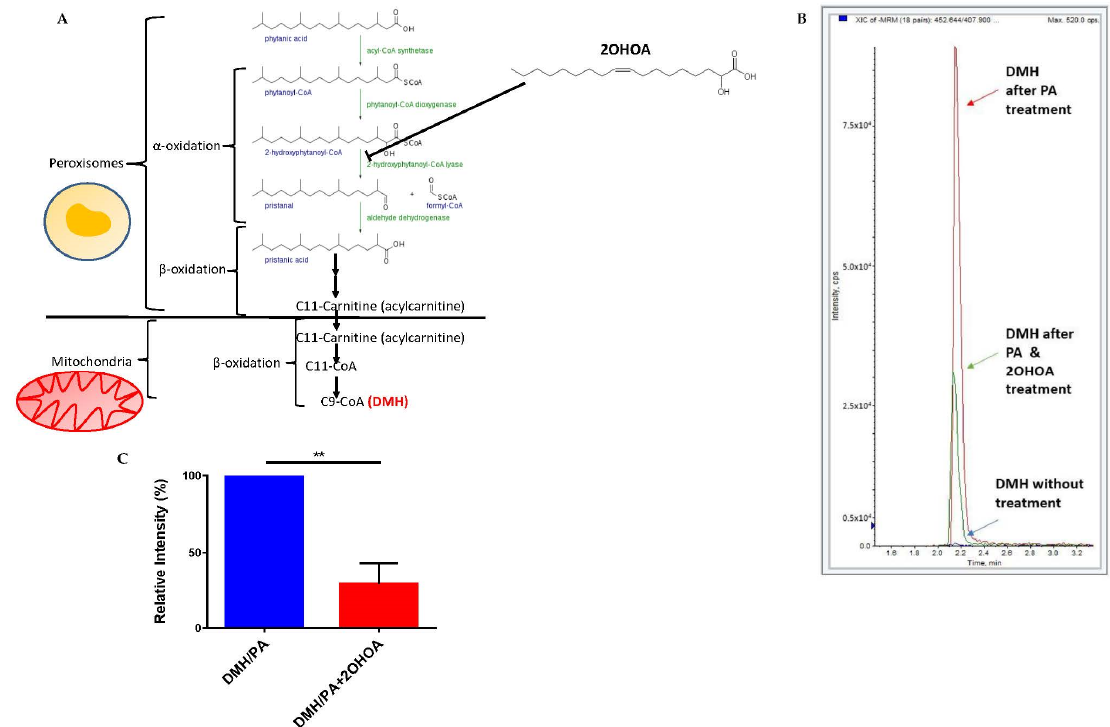
Figure 5. ( A ) A schematic showing the cascade from phytanic acid in peroxisomes to the mitochon- drial β oxidation product C9-CoA (DMH) and the proposed involvement of 2OHOA in this cascade. ( B ) U118MG cells were treated with phytanic acid as a precursor for β oxidation of fatty acids in mitochondria (PA). The production of the specific β oxidation product dimethylheptanoyl coenzyme A (DMH) was analyzed in cells by mass spectrometry after 48 h with PA alone, PA and 200 µ M 2OHOA, or without adding any substance at all. The results show a clear inhibition of β oxidation by 2OHOA, as quantified in ( C ) ( n = 3, mean ± SEM; **, p < 0.01, Student’s t